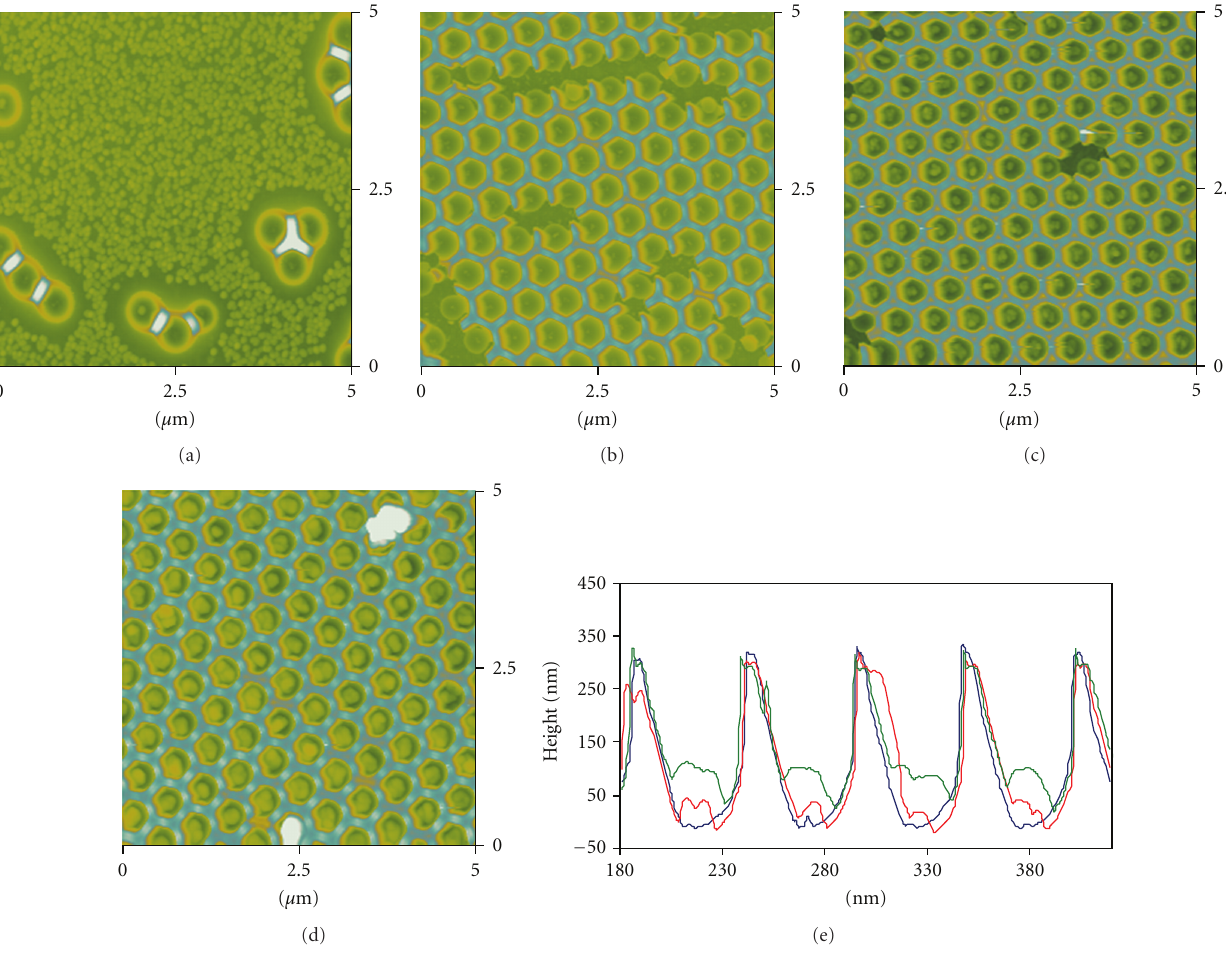
Figure 3: 5 µ m × 5 µ m AFM images of gold deposited on (a) a bare gold electrode (electroless deposition for 6 minutes) and in silica nanowells grown by electroless deposition for (b) 1 minute, (c) 15 minutes, and (d) 3-hour exposure times. (e) Cross-section plots overlaid for clarity (blue = 1 min, red = 15 min, and green = 3